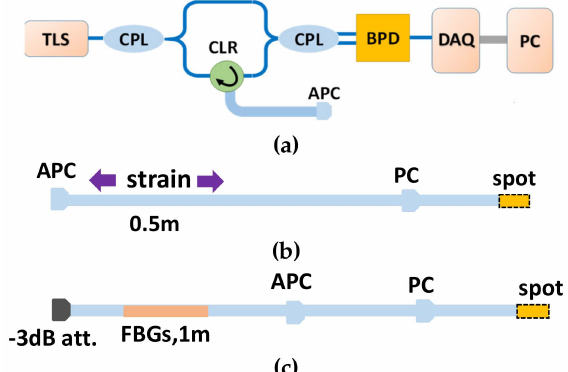
Figure 8. OFDR system using the self-reference method for nonlinearity correction. ( a ) Basic OFDR interrogation system. ( b ) Configuration 1, composed of a single-mode fiber. ( c ) Configuration 2,